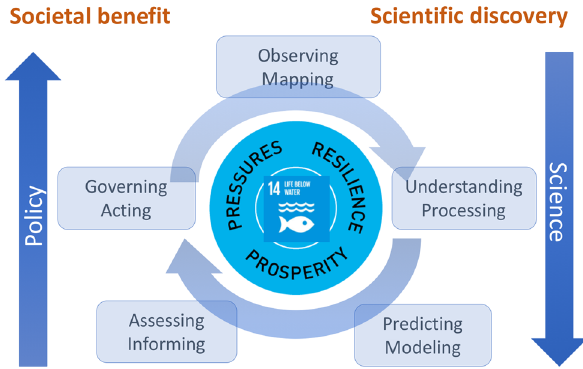
Fig. 2 Increased need for ocean information to meet societal